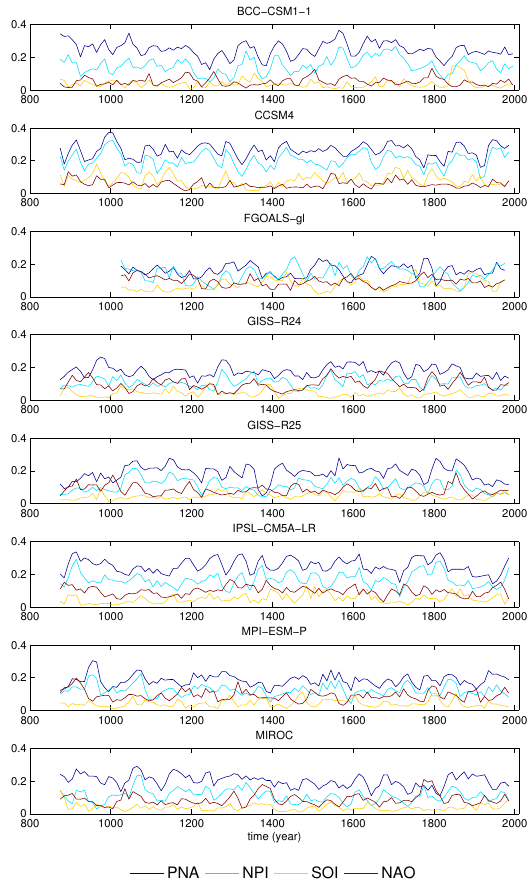
Figure 6. Fractions of total variance of North American winter sur- face air temperatures (land only grid points within the domain 20– 70 ◦ N, 190–300 ◦ E) explained by winter PNA, NPI, NAO and SOI indices for individual models. Values are calculated over decadally paced 30-year